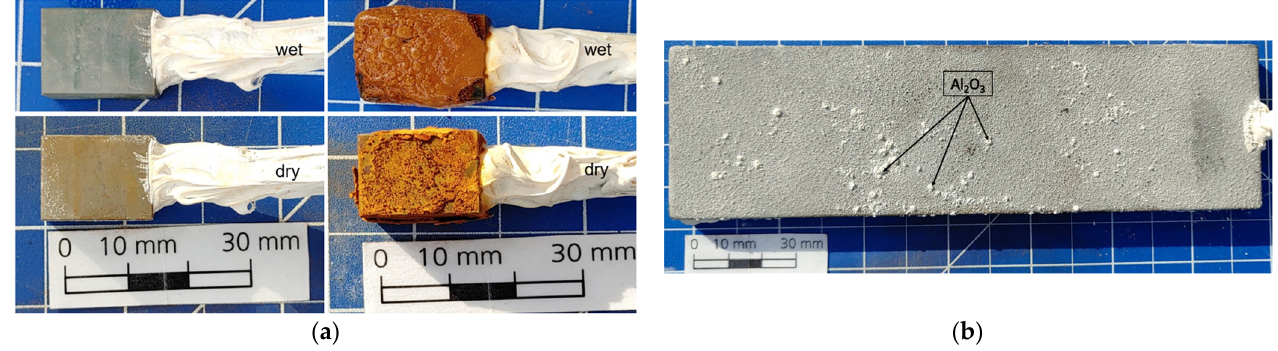
Figure 13. ( a ) Bare steel specimens after 30 days of immersion in Baltic sea water; ( b ) a thermal spray coated specimen that was electrically coupled to a bare steel specimen.